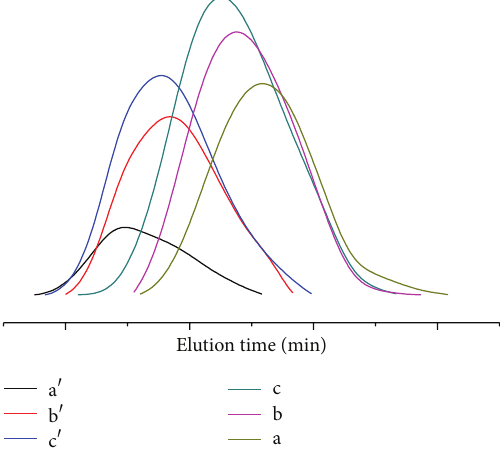
Figure 4: GPC diagrams of PHB-diols (a, b, c) and PUHE copoly- mers (a 󸀠 , b 󸀠 , c 󸀠 ). (a) Reaction time: 8 h; (b) reaction time: 6 h; (c) reaction time: